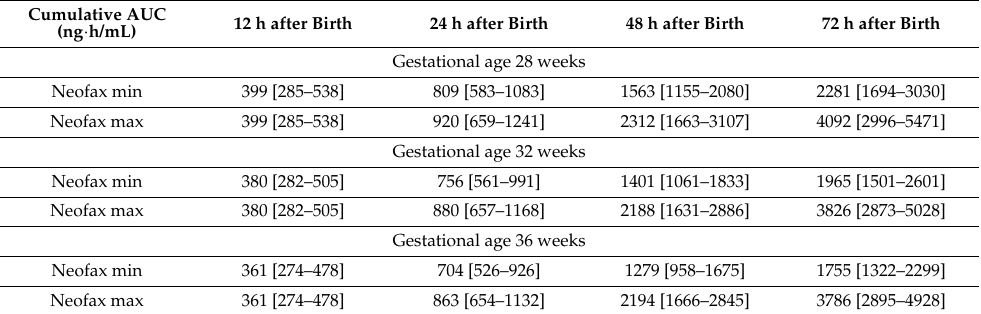
Table 3. Overview of predicted cumulative AUC during the first 72 h after birth for three different gestational age groups. Applying Neofax minimum and maximum dosing regimens [21].